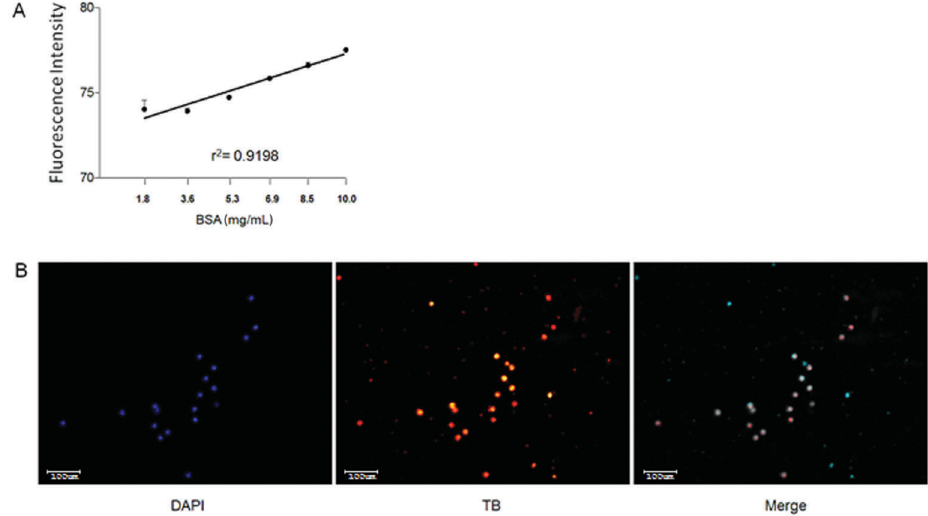
Figure 2. Fluorescence analysis of the trypan blue (TB)-bovine serum albumin (BSA) interaction. A , Increasing BSA concentrations were added to 0.002% TB solution. The fluorimeter was configured to use fixed excitation and emission wavelengths at 488 and 660 nm, respectively. B , Human PBMC co-stained with DAPI and TB. DAPI excitation at 365 nm and the emission band-pass filter DAPI-445/50, TB excitation at 488 nm and fluorescence emission detected by